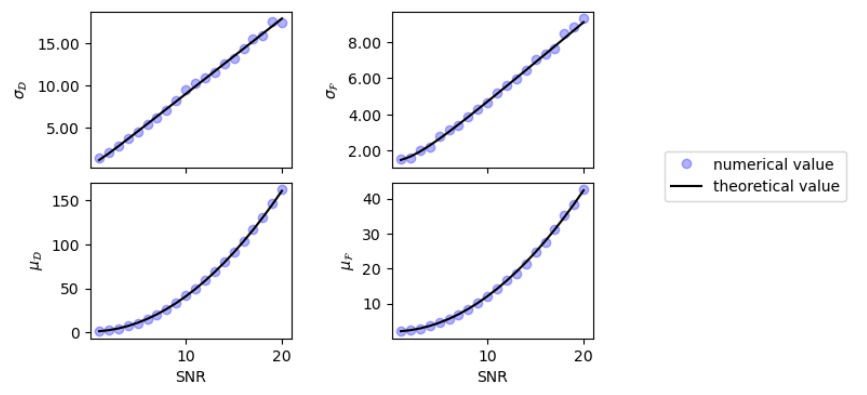
Figure 1. Simulated mean µ and standard deviation σ of the F -statistic ( left panels) and the D - statistic ( right panel) for an array of SNRs. Continuous lines are the theoretical predictions.